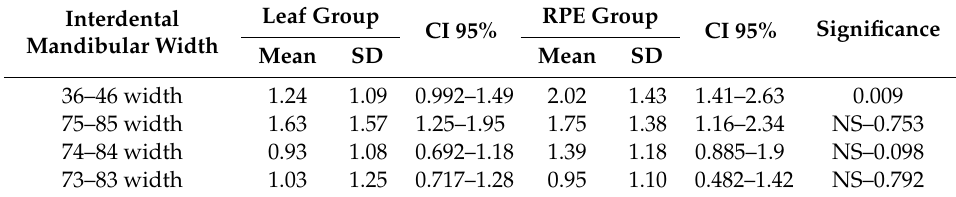
Table 7. T-Test for independent samples comparing the net ( ∆ T1 − T0) interdental width (mm) increase after Leaf (n ◦ 69) or RPE treatment (n ◦ 21)—mandibular